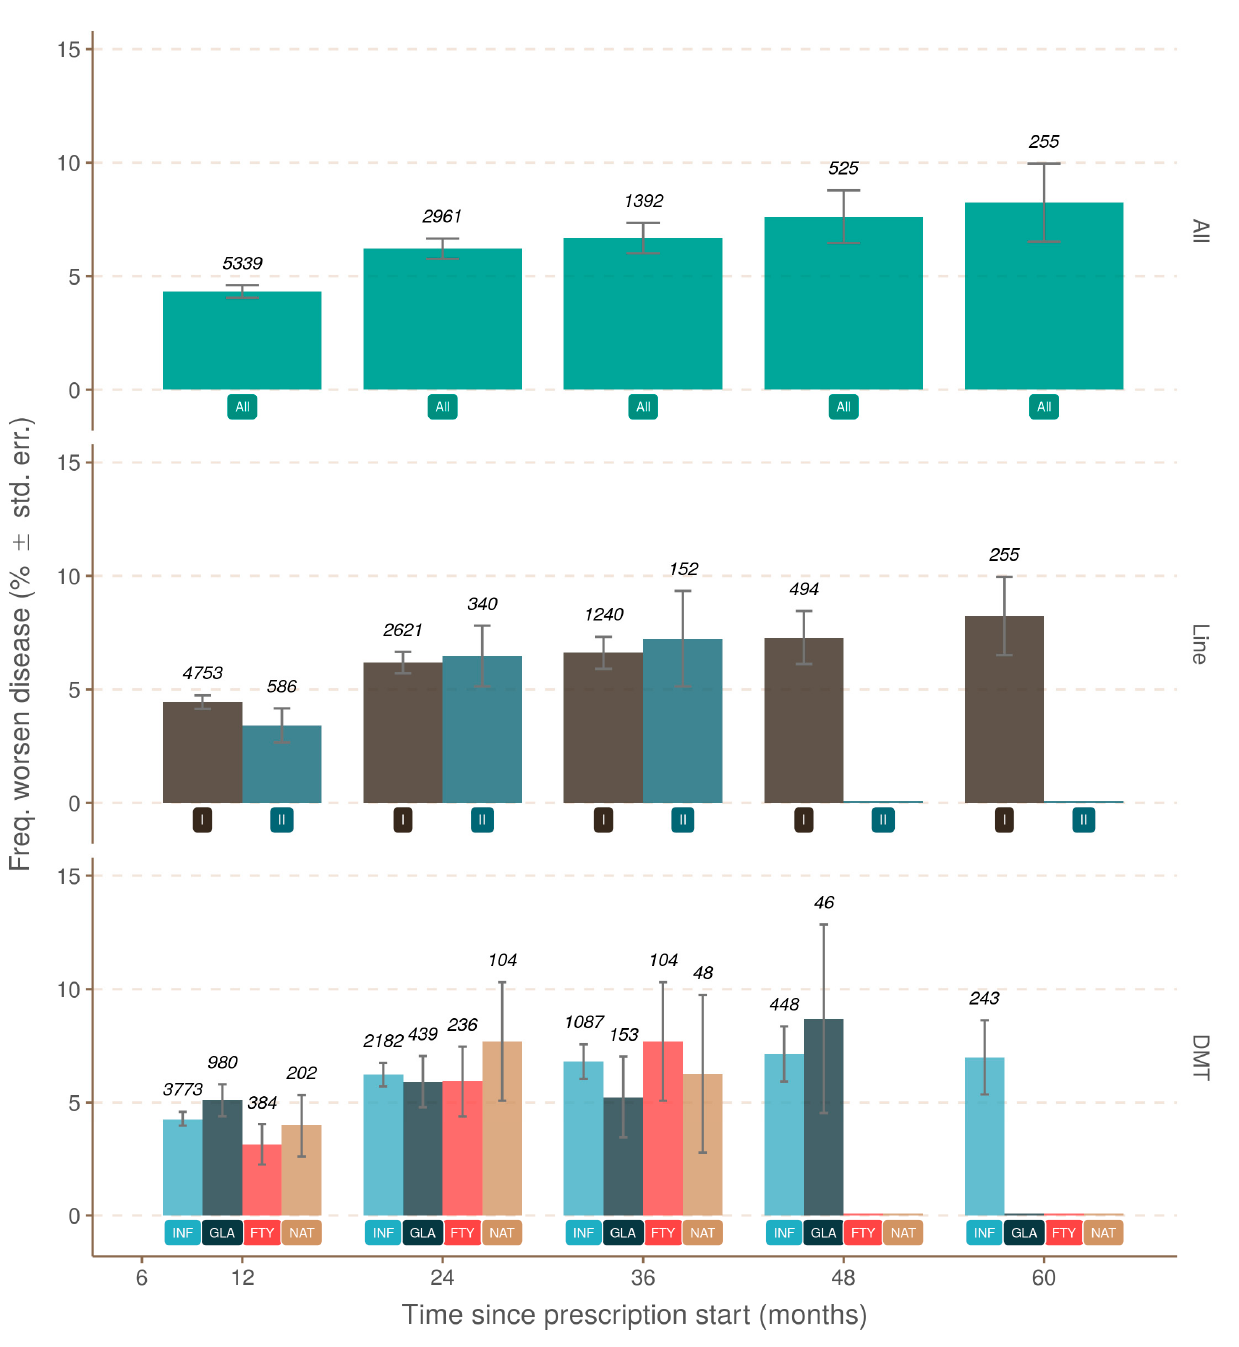
Figure 1. Comparison between observed frequencies of worsening diseases and month of observation when no relapse was ever recorded. The upper pane uses the complete set of observations (green; label at y = 1 is “All”), the middle pane uses first- and second-line treatment (label at y = 1; first-line, dark brown; second-line, dark blue), and the lower pane uses drug (label at y = 1; Fingolimod, red, FTY; Glatiramer Acetate, dark blue, GLA; Interferon, blue, INF; Natalizumab, light brown, NAT). Abundance is represented by transparency and the figure at the top of each bar. The error bar represents the standard error estimated as p × (1 − p)/ n , with p being the number of positives and n the total number of observations. DMT: disease-modifying therapy.